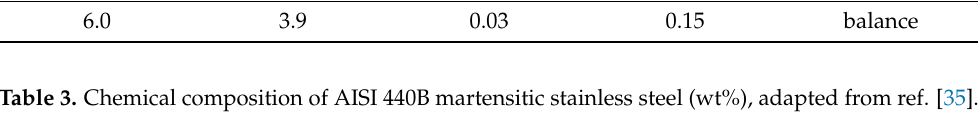
Table 3. Chemical composition of AISI 440B martensitic stainless steel (wt%), adapted from ref. [35]. C Cr